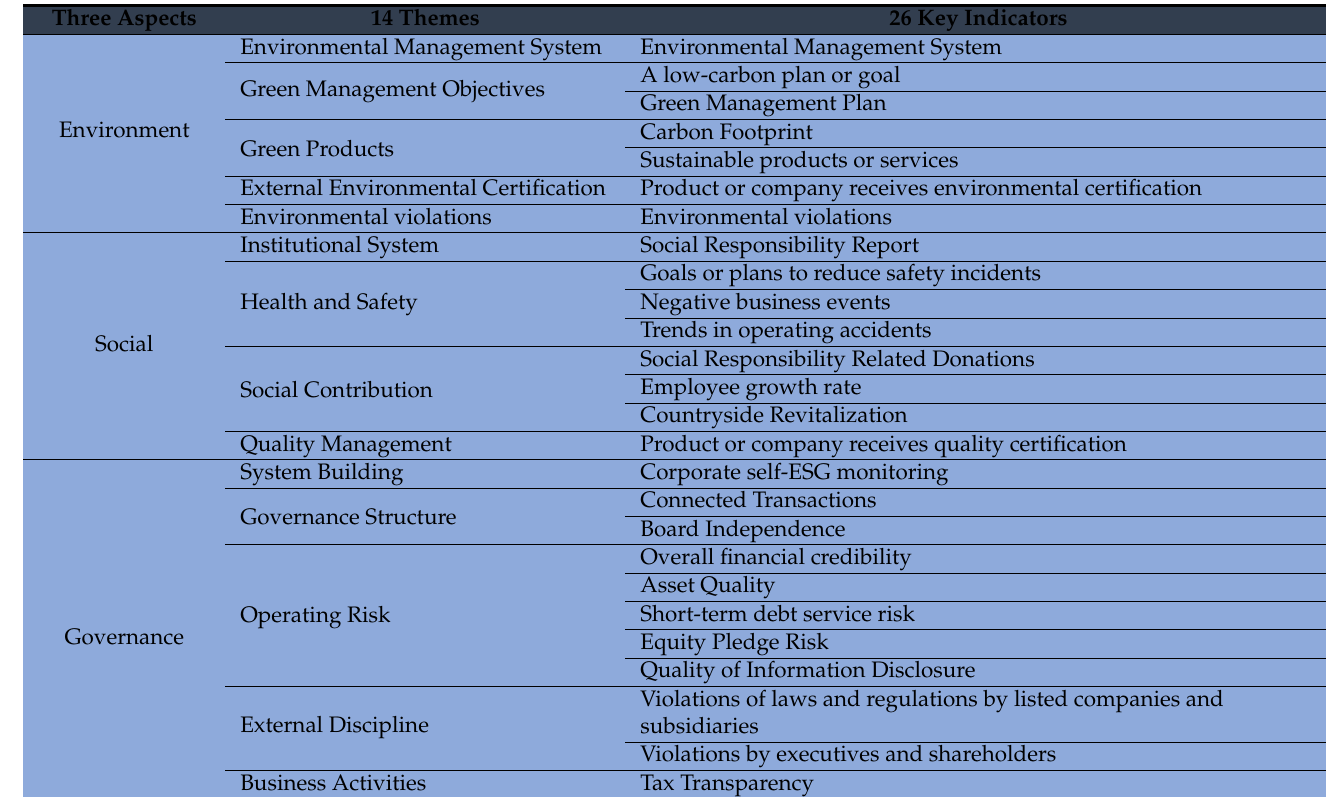
Table 1. Composition of Sino-Securities ESG Index specific rating indicators.